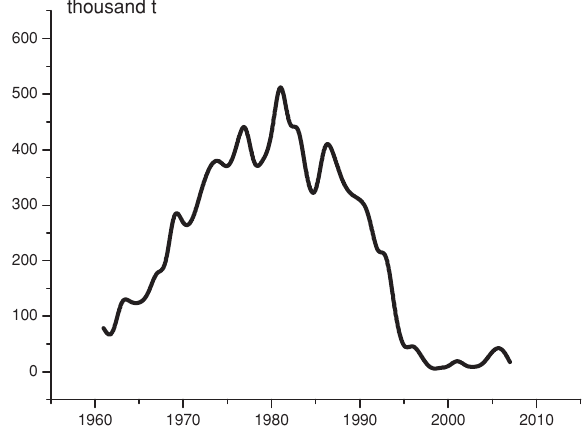
Figure 1. Dinamics of Hungarian fresh apple export (1961–2007) Source: FAO Faostat® database